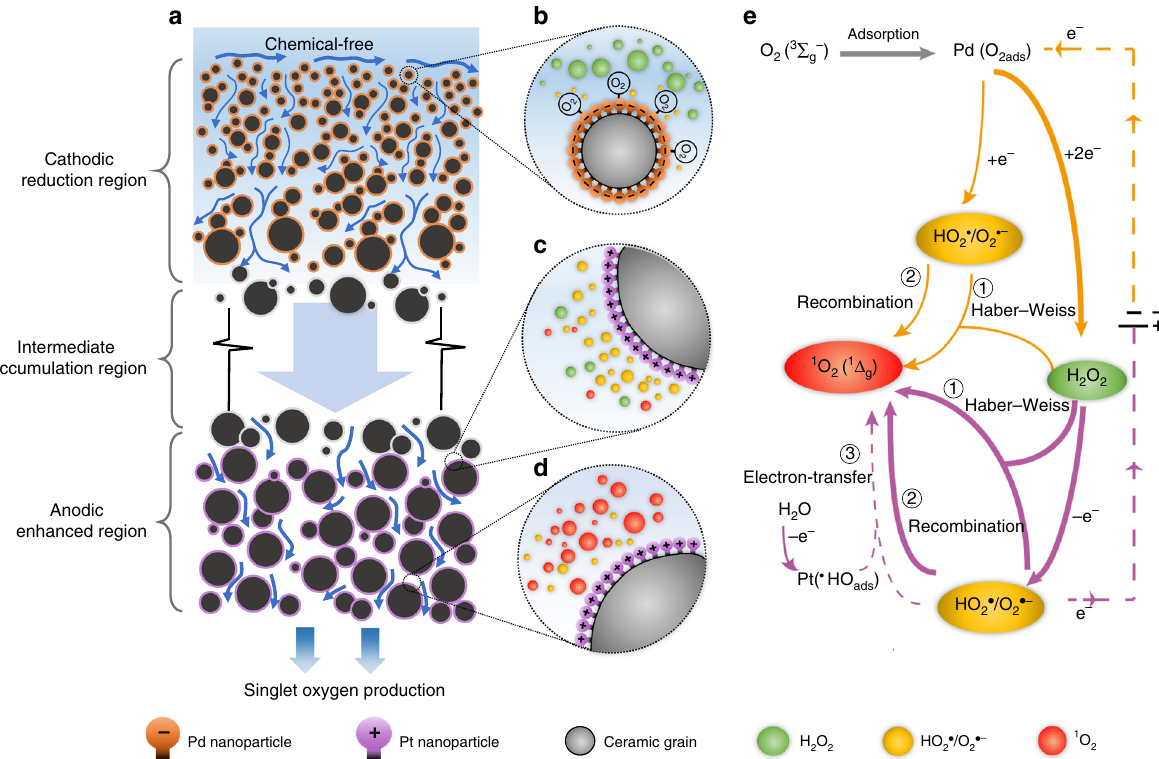
Fig. 4 Proposed mechanism for 1 O 2 production by the electrocatalytic Pd – Pt – CM fi ltration. a Schematic describing the various regions in the Pd – Pt – CM. b Schematic of the cathodic Pd-functionalized (black and orange core – shell balls) membrane region, where H 2 O 2 (green balls) and O 2 (cid:129) − (yellow balls) are generated via oxygen reduction in close vicinity to the Pd-functionalized pores. c Anodic Pt-functionalized (black and purple core – shell balls) membrane region, where H 2 O 2 consumption, O 2 (cid:129) − accumulation, and 1 O 2 (red balls) generation occur concurrently. d A zoom-in close-to-bottom Pt-functionalized channel, where 1 O 2 is released throughout the permeate fl ow. e Proposed reaction pathway of singlet oxygen production. The orange and purple arrows represent the reactions occurring in the cathodic reduction region and anodic enhanced region, respectively. Dashed lines linked to the electric power supply denote the electron